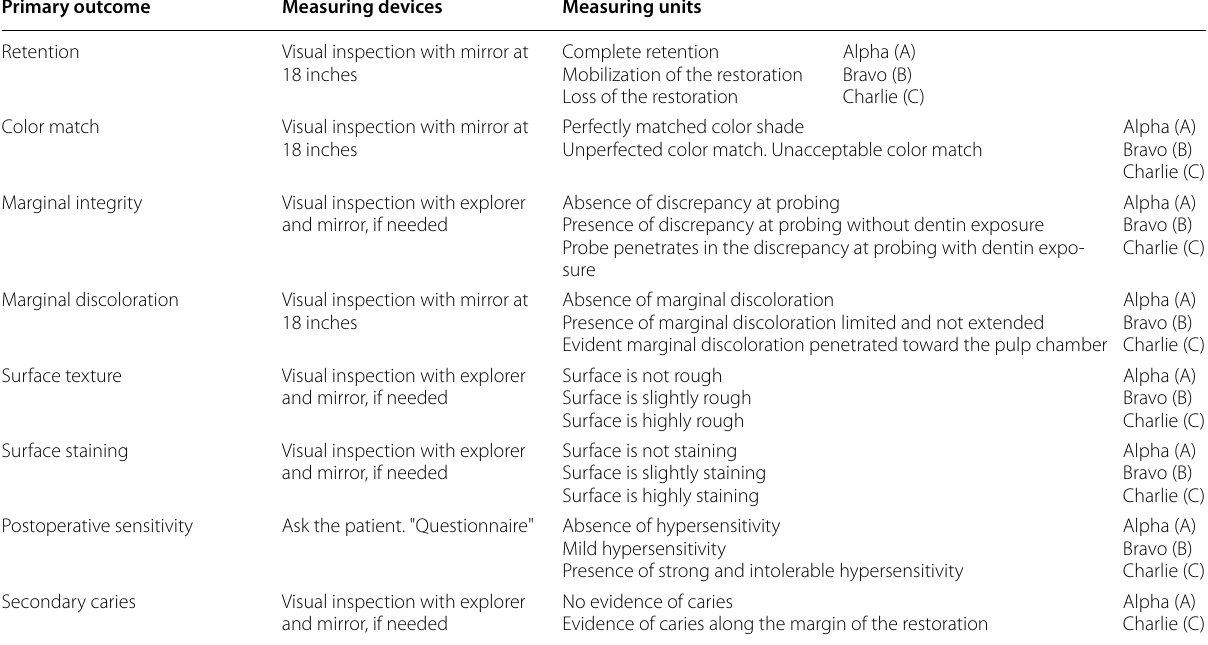
Table 3 Primary outcome, measuring devices and measuring units for in vivo study using modified (USBHS)